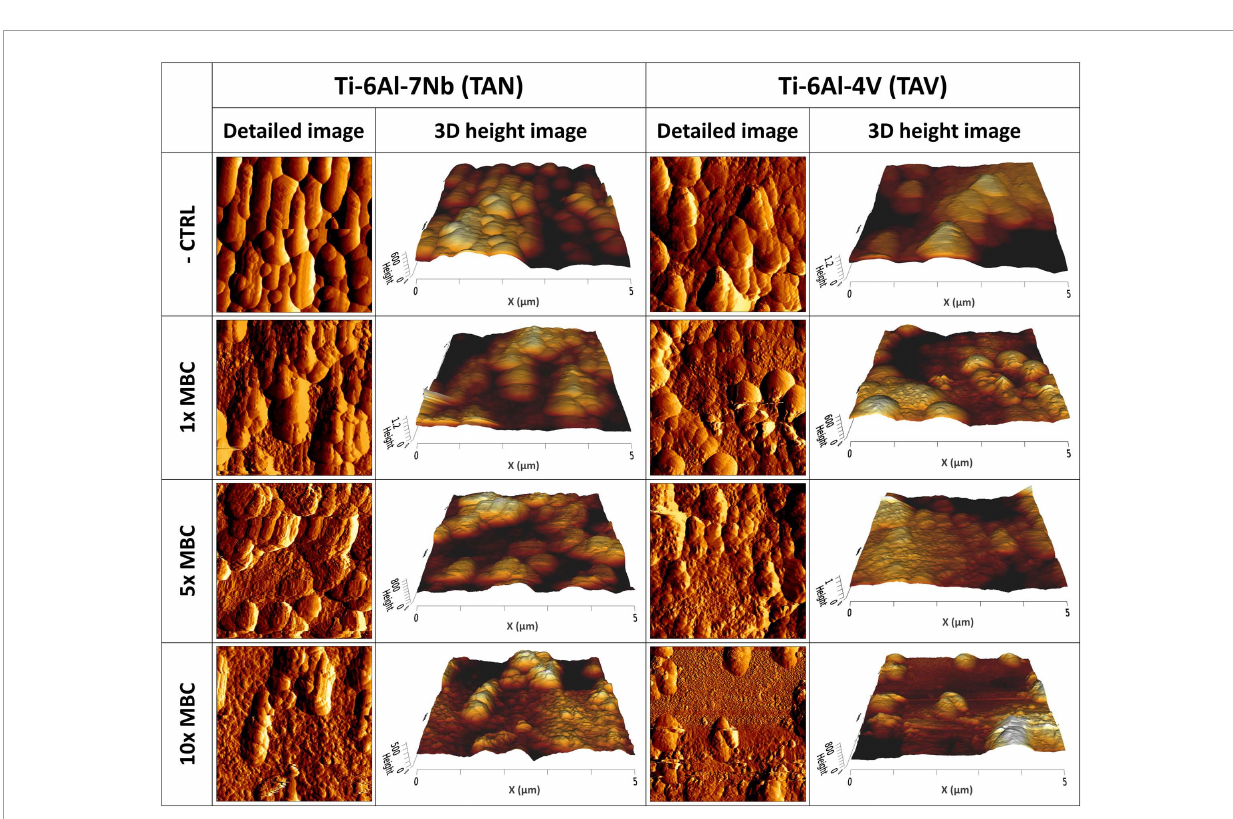
FIGURE4 Atomic force microscopy images of mature 7-day biofilms cultured on implant materials: (Left) Ti-6Al-7Nb (TAN); (Right) Ti-6Al-4V (TAV) after 24 h exposure to 1-, 5- and 10-times the MBC of rifampicin (RIF) and ciprofloxacin (CIP). Per material and per concentration a detailed 5 µ m × 5 µ m image and a 3D height image are